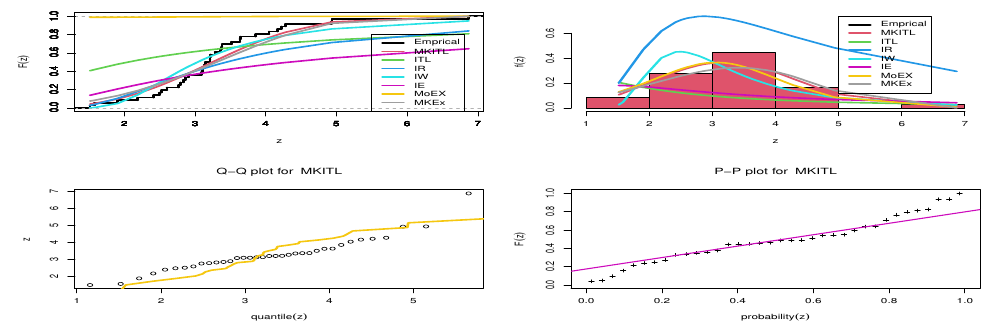
Figure 3. Cumulative function and empirical CDF, histogram, Q-Q plot and P-P plot for the MKITL distribution for COVID-19 data of Canada.